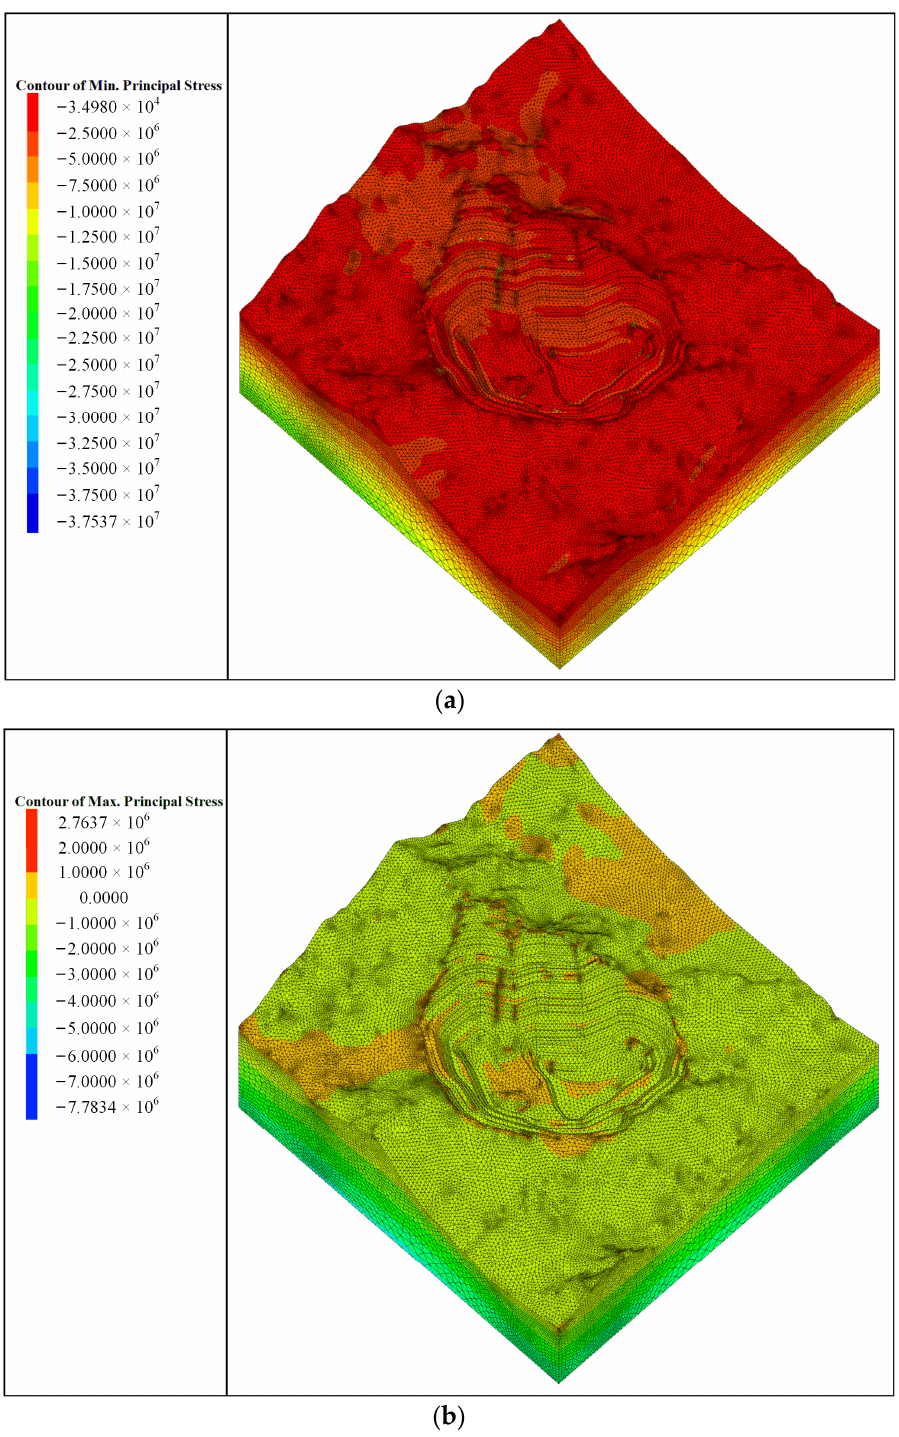
Figure 7. The principal stress diagram of the overall model: ( a ) minimum principal stress diagram; ( b ) maximum principal stress diagram.